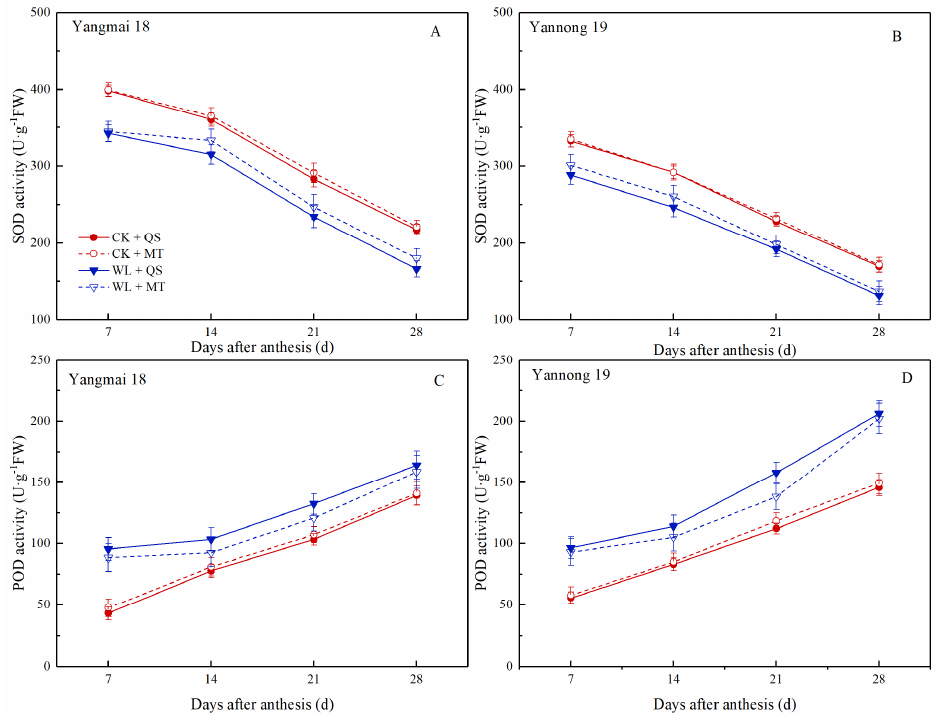
Figure 4. Post-flowering changes in root superoxide dismutase (SOD) and peroxidase (POD) activities of Yangmai 18 ( A , C ) and Yannong 19 ( B , D ) under different treatments, i.e., CK + QS: leaf spraying with distilled water under non-waterlogged conditions; CK + MT: leaf spraying with 100 μmol·L −1 of melatonin under non-waterlogged conditions; WL + QS: leaf spraying with distilled water under waterlogged conditions; WL + MT: leaf spraying with 100 μmol·L −1 of melatonin under waterlogged conditions. At each measurement, the SOD activity of the waterlogged roots of the two wheat cultivars was significantly lower than the non-waterlogged roots, and the POD activity was significantly higher in waterlogged than non-waterlogged roots. Compared with non-waterlogged roots, waterlogged roots experienced a 122% increase in the POD activity of Yangmai 18 at 7 DAA (Figure 4C) and a 73.2% increase in the POD activity of Yannong 19 at 28 DAA (Figure